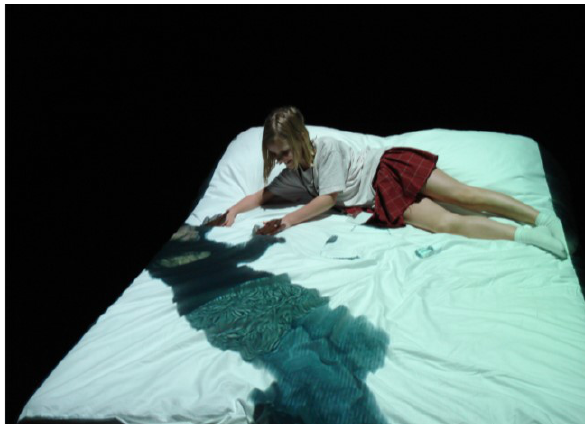
Figure 1 | Paul Sermon, Telematic Dreaming (1992). DAT – Digital Art & Technology. Exhibition view. Ars Electronica Exhibition at the Singapore Science Centre 2007. Image: Ars Electronica. Courtesy of the artist and Ars